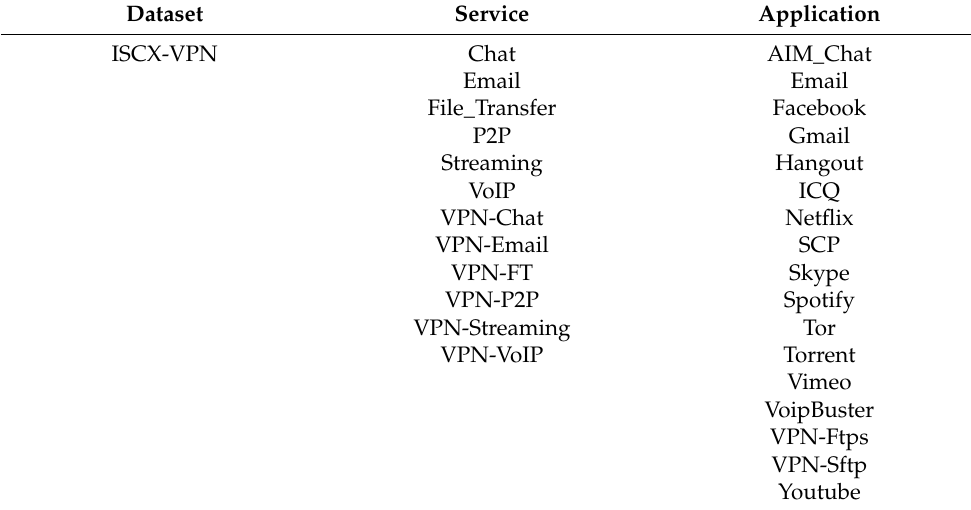
Table 2. Dataset